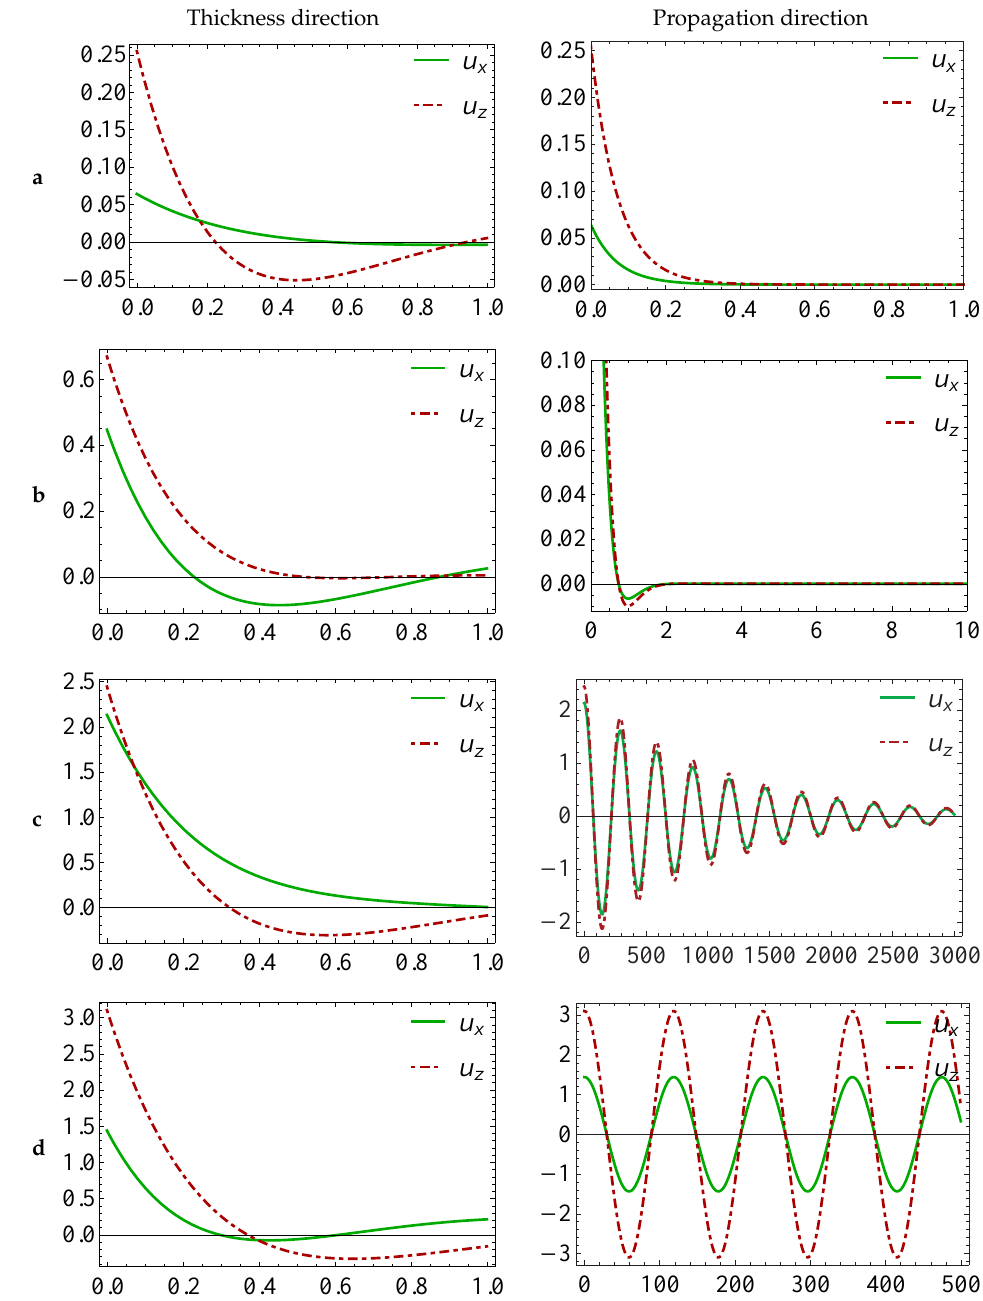
Figure 5. Displacement amplitude field distributions in the thickness z and wave propagation x -directions for the FGPM half-space, the results got at x = 0 and z = 0, respectively, with f = 22.3825: ( a ) k = 13.9275 i ; ( b ) k = 2.1286 + 3.5681 i ; ( c ) k = 0.0214 + 0.0010 i ; and ( d ) k =